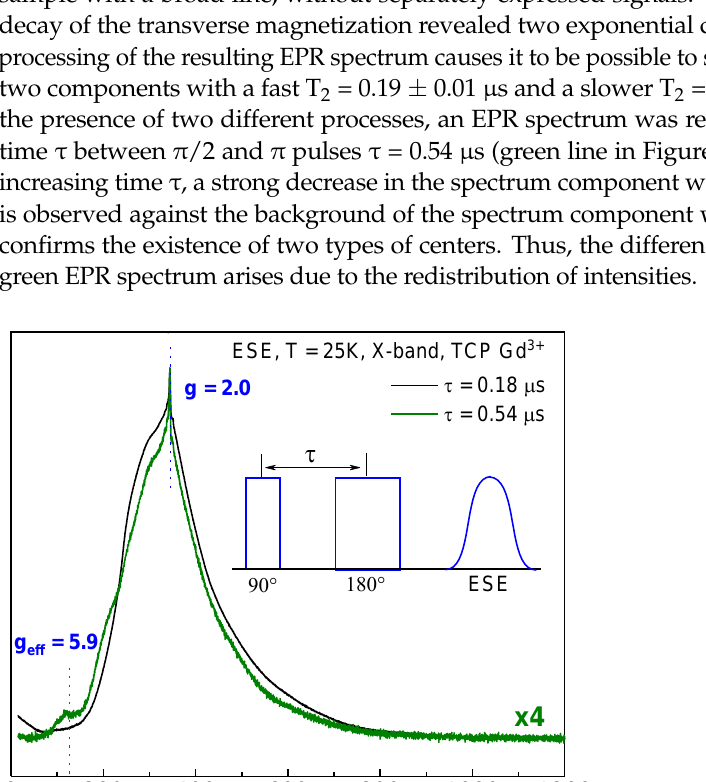
Table 1. The zero-field (fine structure) parameters of Gd 3+ spin ‒ Hamiltonian.